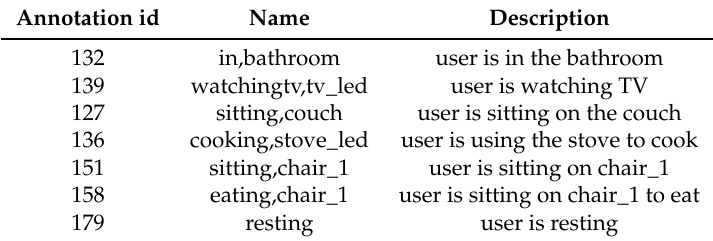
Table 2. List of activities labeled by the user living in the apartment, where location_id = 211 and name = ORU/Home1 .